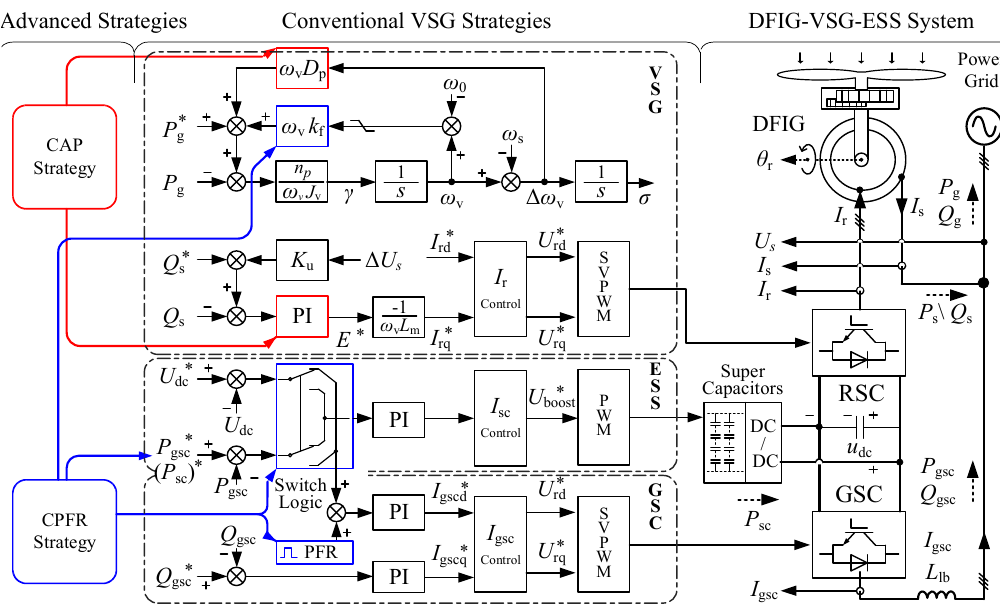
Figure 2. Topology and overall control diagram of the system.